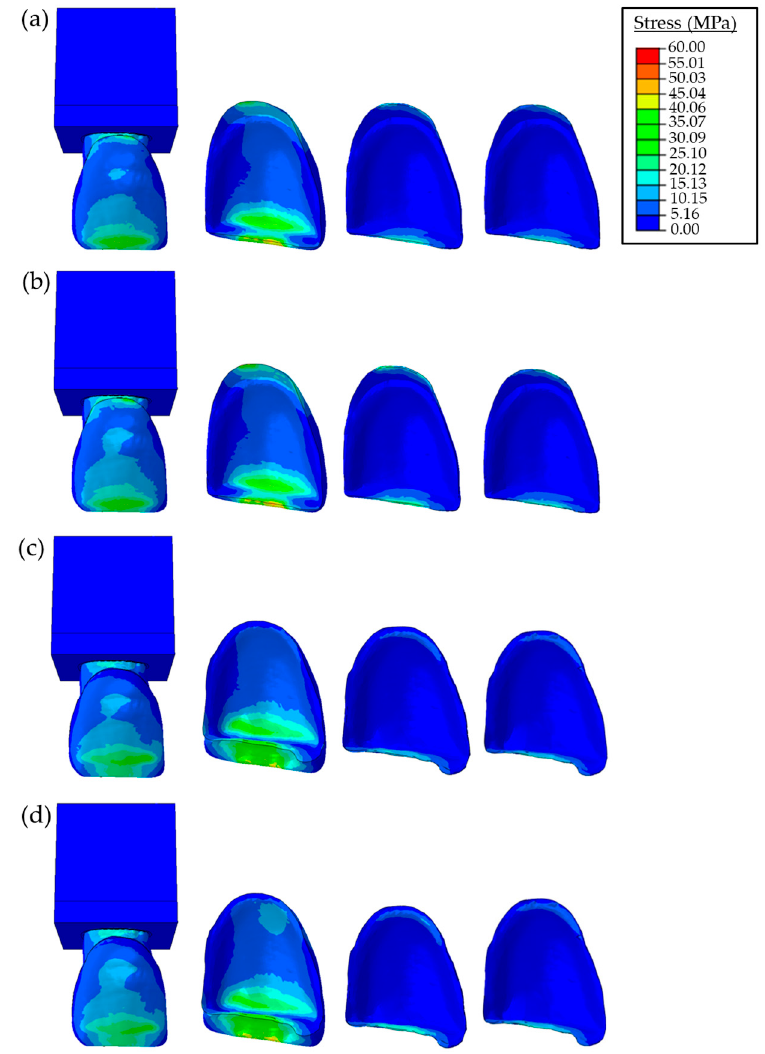
Figure 6. Stress distributions due to an oblique force of 50 N with 60° angle in the restored teeth, porcelain laminate veneer, resin cement, and adhesive layer, respectively. Butt joint preparation using ( a ) low modulus and ( b ) high modulus resin cement, and palatal chamfer restoration using ( c ) low modulus and ( d ) high modulus resin cement.